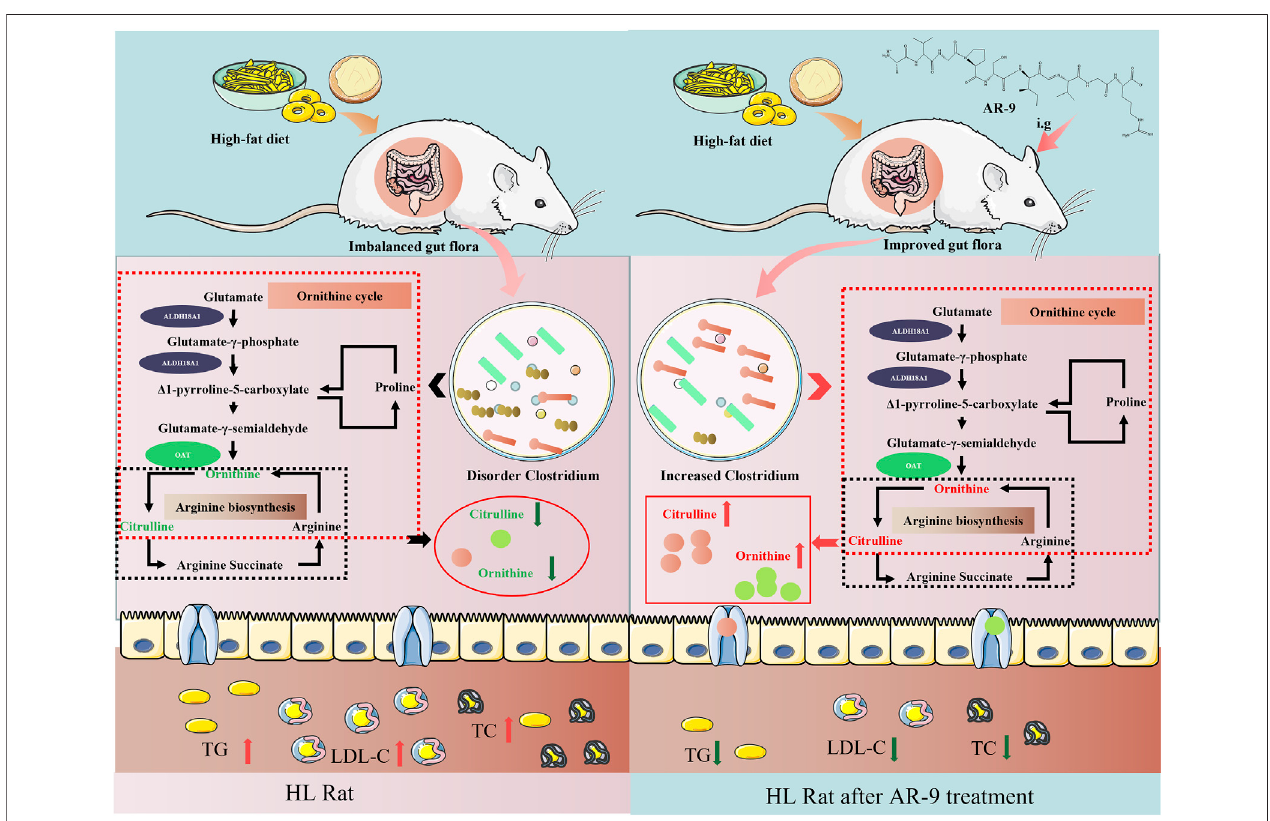
FIGURE 7 | Effects of AR-9 in the rat with HL. The green arrows indicate downregulation effects, and the red arrows represent upregulation effects.